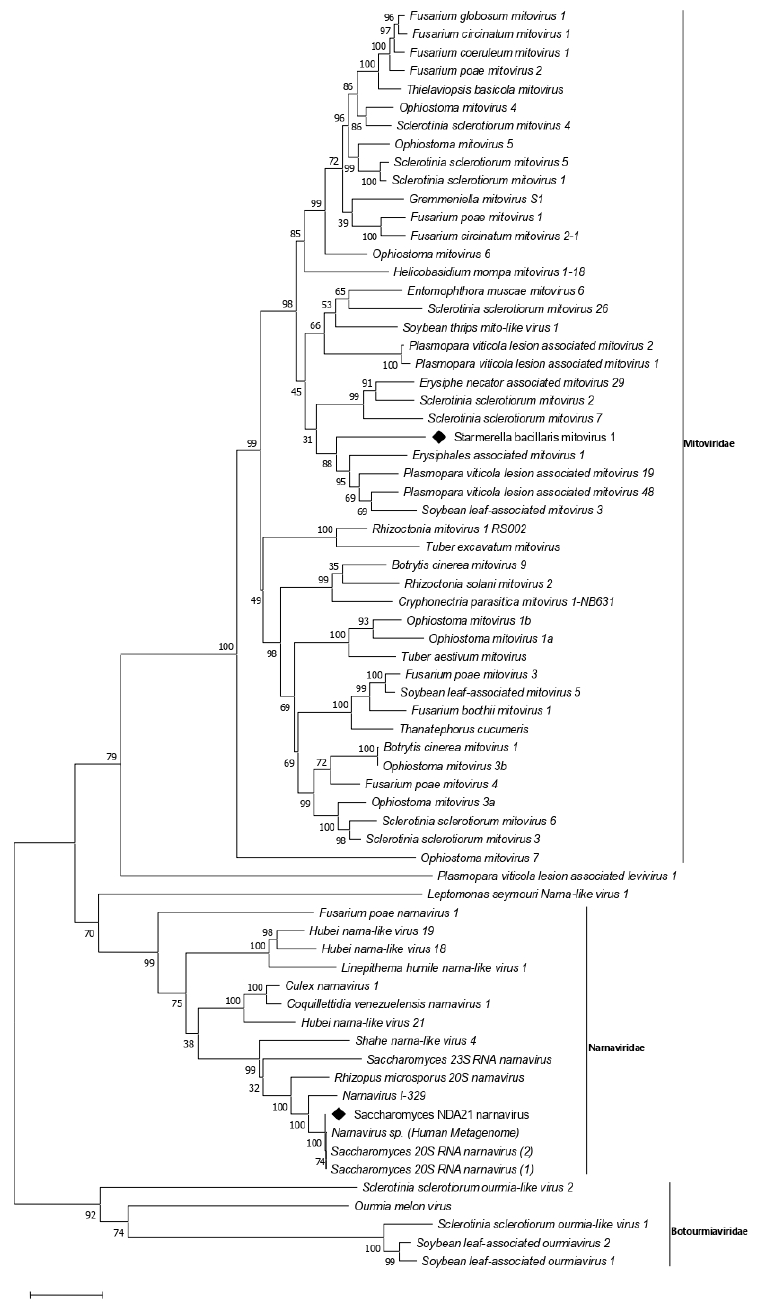
Figure 3. Phylogenetic analysis of Saccharomyces cerevisiae narnavirus NDA21 (ScNV-NDA21) and Starmerella bacillaris mitovirus 1 (SbMV1-Cz12). Maximum-likelihood tree was constructed based on the alignment of RdRp amino acid sequences. Bootstrap values reported at the nodes are from 1000 replicates. Sequences determined in this work are indicated by (cid:7)